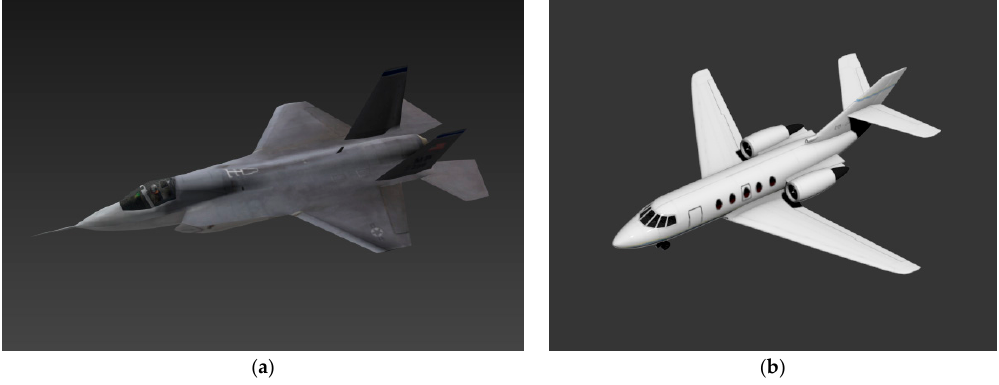
Figure 10. Two aircraft models: ( a ) F35 model; ( b ) Cessna model.